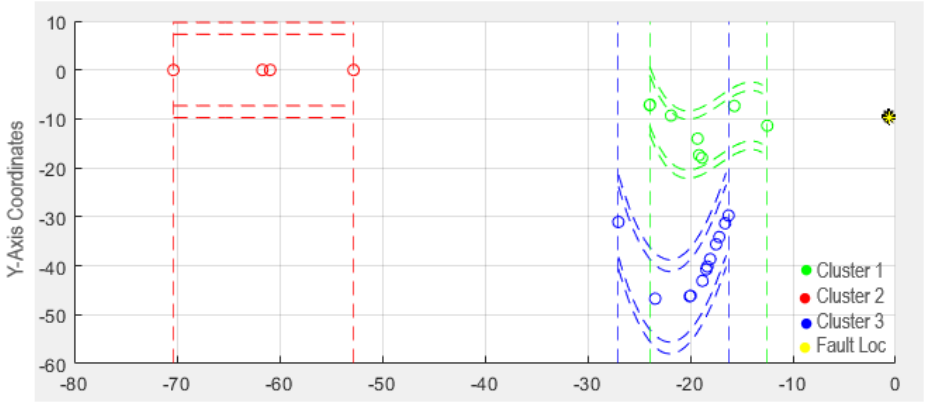
Figure 15. 10 Ω fault identified.